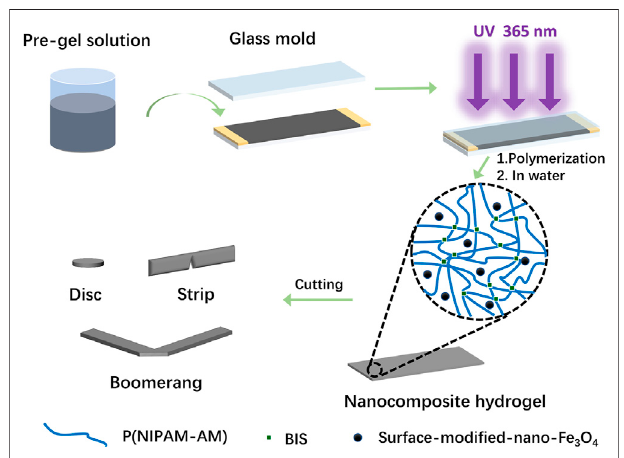
FIGURE 1 | Schematic illustration of the preparation of P (NIPAM-AM)/ Fe 3 O 4 nanocomposite hydrogel